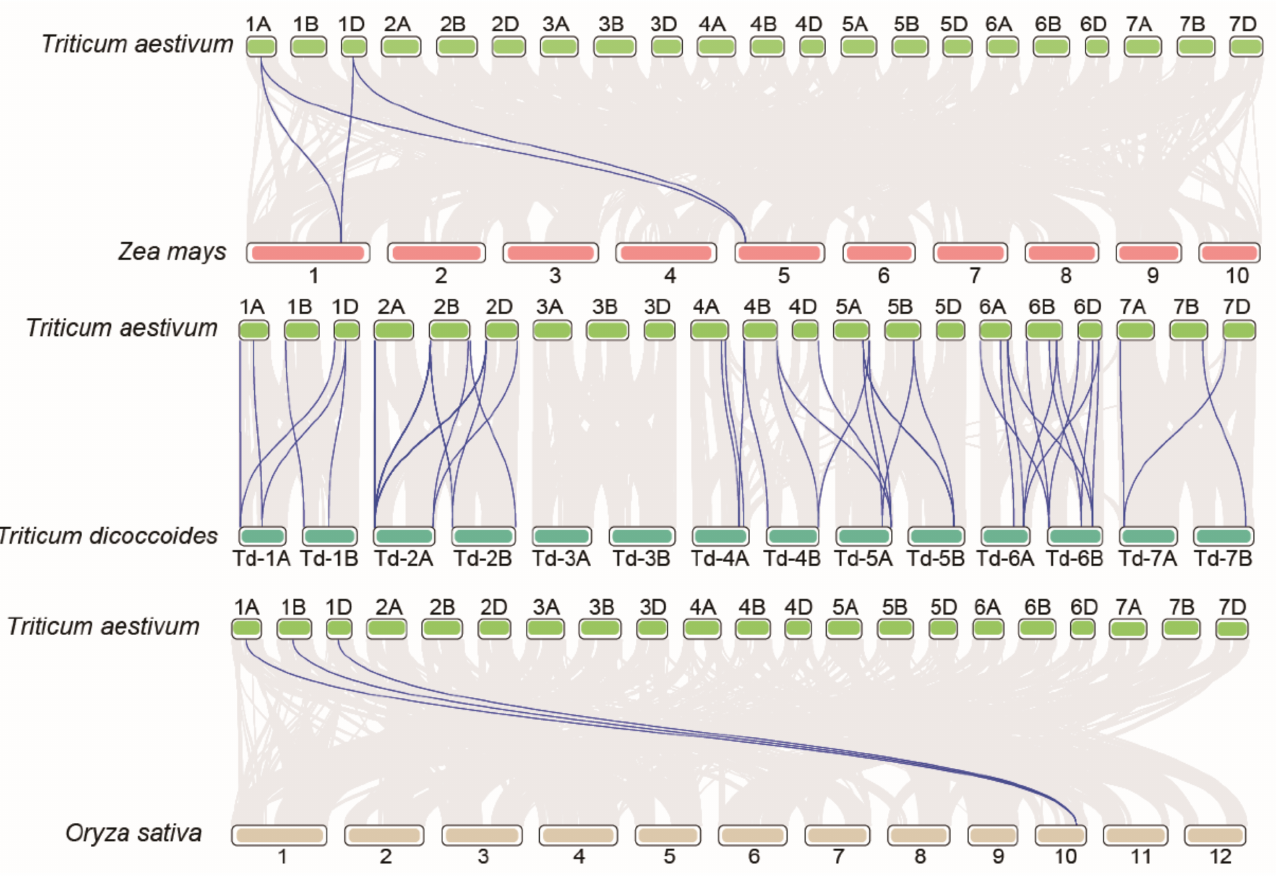
Figure 5. Synteny analysis for PKS genes in wheat and representative species comprising T. dicoccoides , maize, and rice. The gray lines in the background represent the synteny regions in wheat and the genomes of other species, and the blue lines represent the PKS gene pairs with synteny in wheat and other